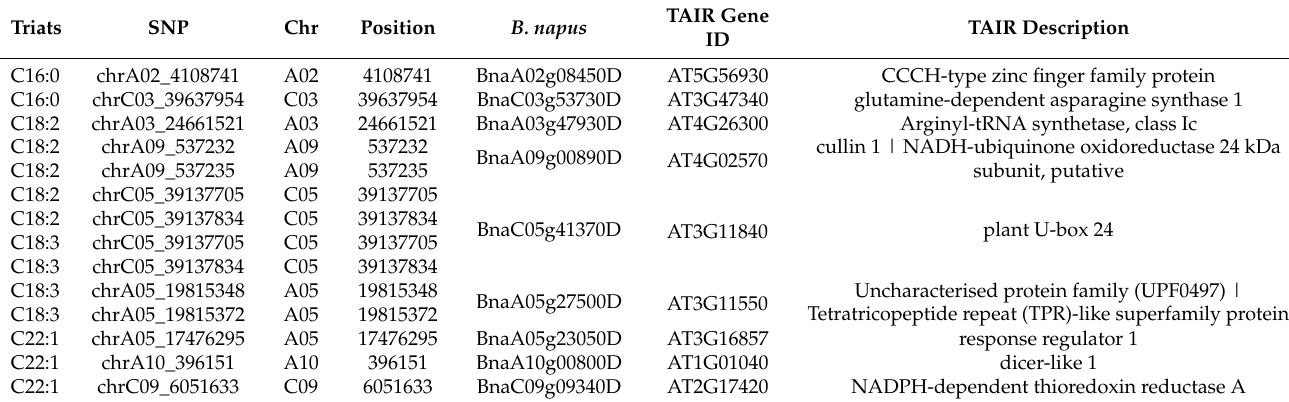
Table 5. Summary of SNPs and genes to enrichment of reproductive process in BP